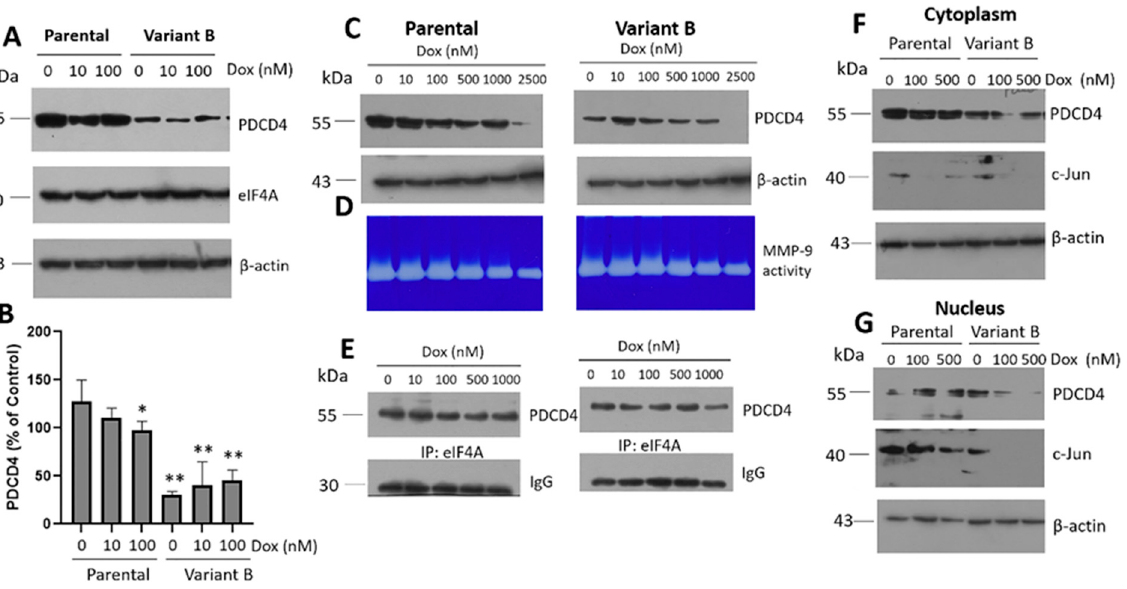
Figure 3. Doxorubicin (Dox) induces the disruption of PDCD4/eIF4A complex. ( A ) WB of PDCD4 and eIF4A under 10 and 100 nM Dox treatment in parental cells and variant B. ( B ) Densitometry analysis of PDCD4, results are reported as mean ± SD (n = 3) and expressed as % of control; * p < 0.1, ** p < 0.001 respect to control of parental cells. ( C ) PDCD4 expression is affected by increasing doses of Dox (0–2500 nM) in both, parental and variant B cells. Under the same conditions, MMP-9 secretion was analyzed on a conditioned medium using gelatin-substrate gels ( D ) and the interaction of PDCD4/eIF4A complex ( E ). ( F , G ). Cellular localization of PDCD4 and c-Jun in parental and variant B cells, under increasing concentrations of Dox (0–500 nM). β -actin was used as a loading control, and Lamin B1 in nucleus fractions.